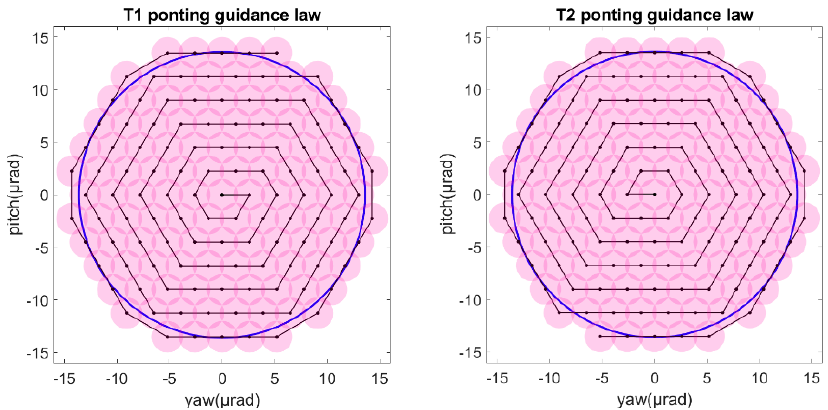
Figure 10. Guidance law for T1 and T2 on satellite A.